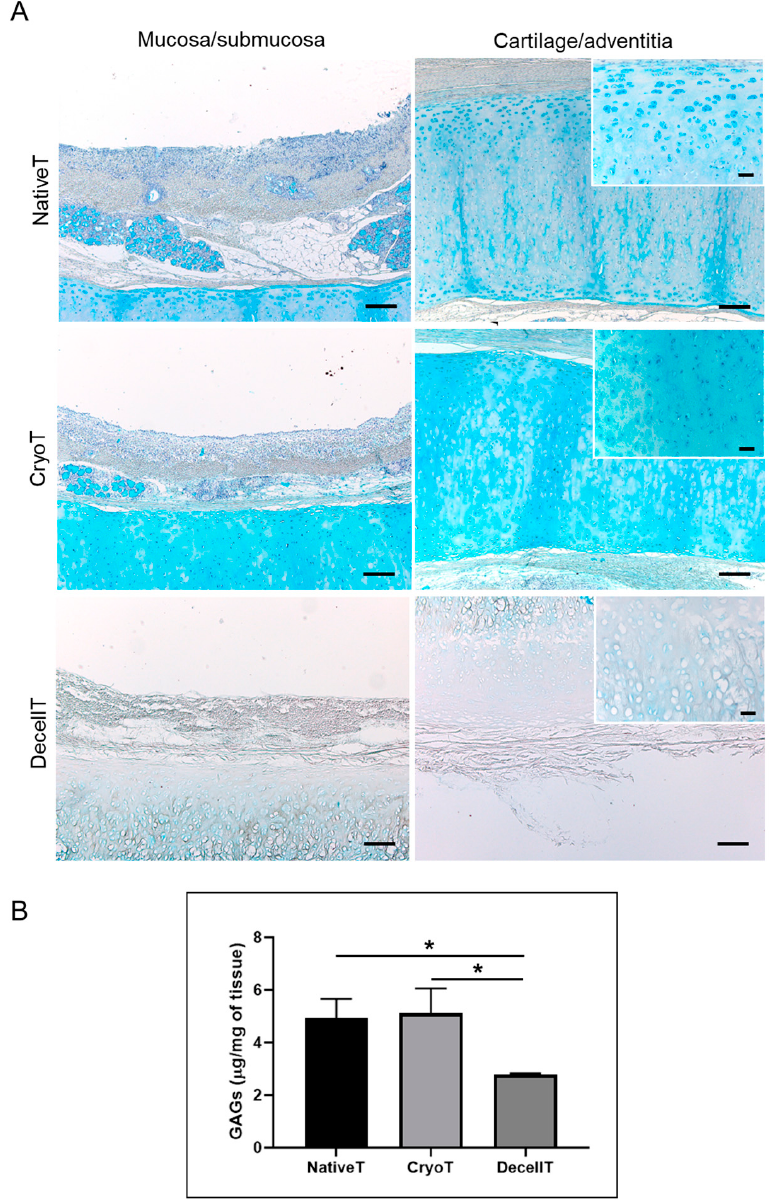
Figure 5. ( A ) Histological appearance of pig tracheas obtained by cryopreservation (CryoT) and decellularization (DecellT) compared with native trachea (NativeT) showed by Alcian Blue staining. The whole tissue thickness was considered. Scale bars: 100 µ m (mucosa/submucosa); 50 µ m (carti- lage/adventitia); 200 µ m (cartilage/adventitia, insert). ( B ) Sulphated glycosaminoglycans (GAGs) quantification, showing a reduction in GAGs content after decellularization (DecellT) compared with cryopreserved tracheas (CryoT) and native tracheas (NativeT) (*: p <